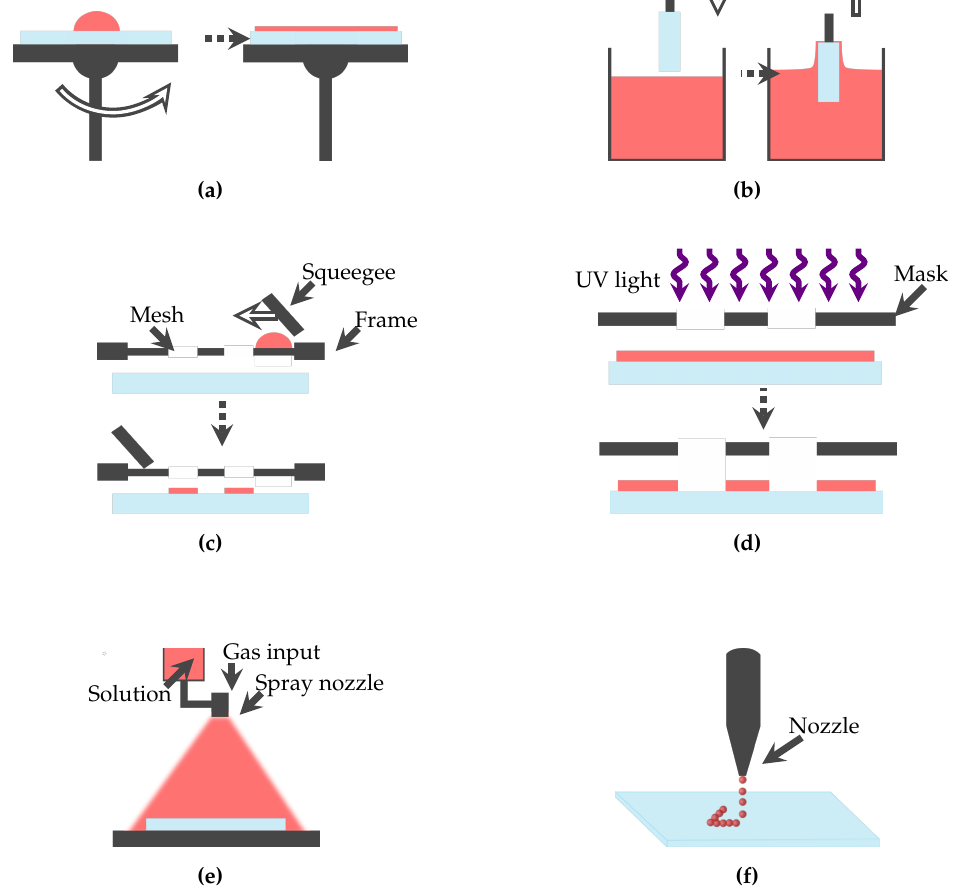
Figure 7. Schematic of typical fabrication methods for ozone sensors. The substrate is shown in blue and the applied ink or thin film material in red. ( a ) The spin-coating process. ( b ) A schematic of dip-coating/immersion. ( c ) The screen-printing process. ( d ) The UV photolithography process. ( e ) The spray-coating/spray pyrolysis process. ( f ) The inkjet-printing